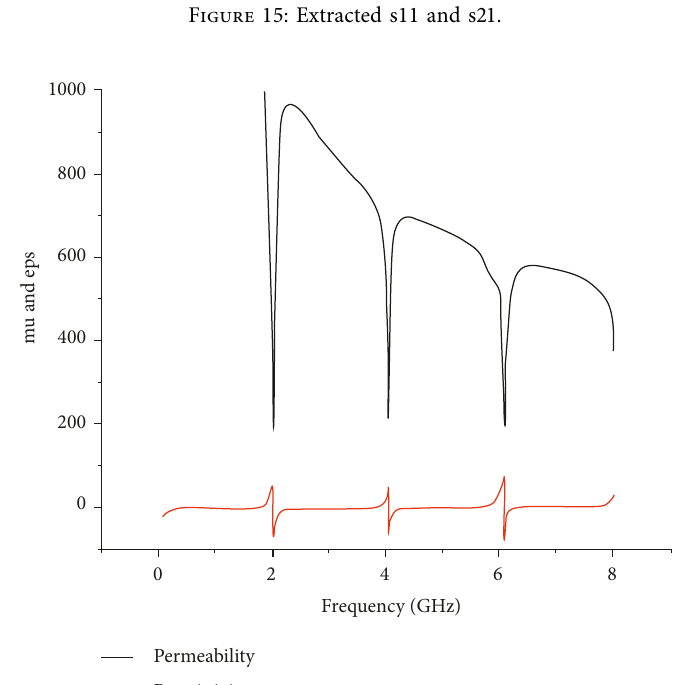
Figure 15: Extracted s11 and s21.